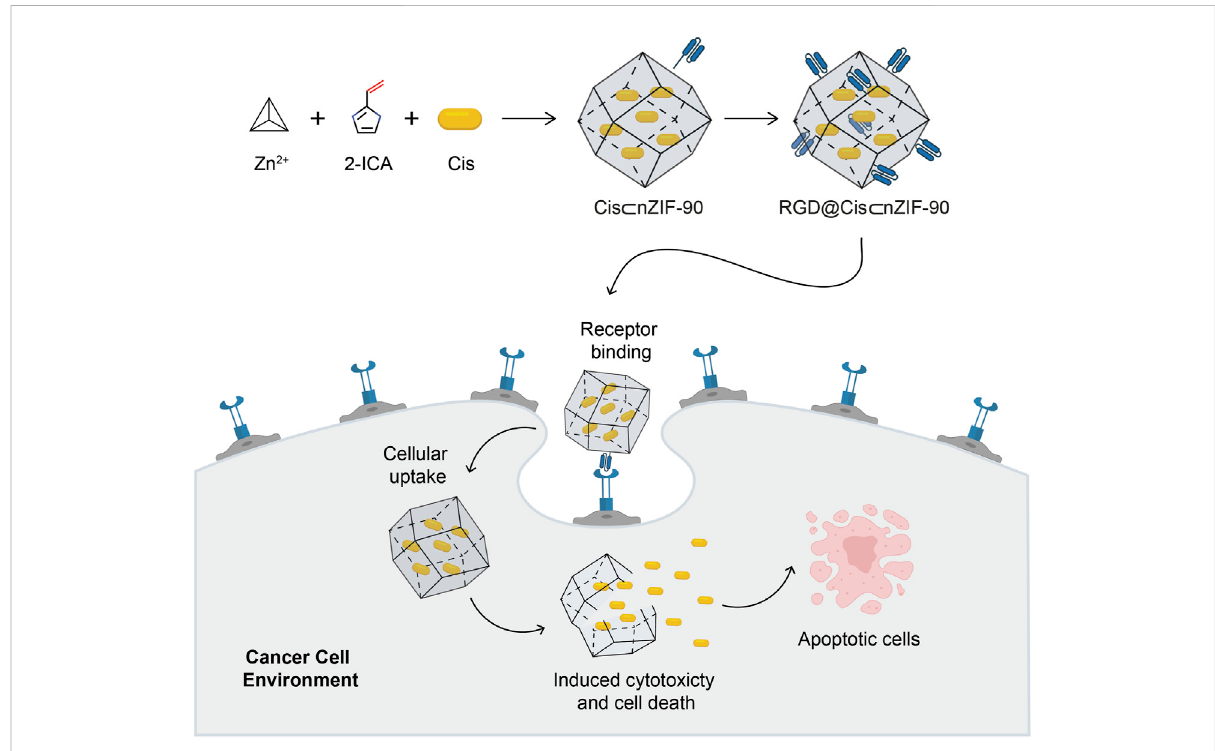
Scheme 1 Schematic illustration for the synthesis of the Cis-encapsulated nZIF-90 modi fi ed with RGD, RGD@Cis ⊂ nZIF-90, and its ability for targeted cancer treatment. Theactive deliverynanosystemiscapableof cellularuptakeandinducing cytotoxicity, celldeath, andapoptosis.Atom colours for 2-ICA: C, black; N, blue; O,